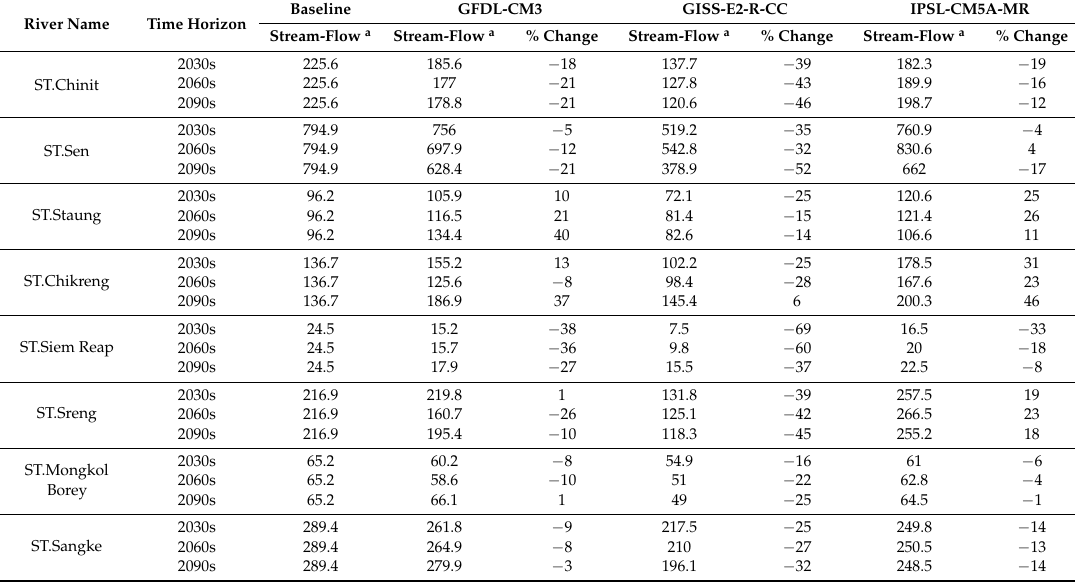
Table 6. Percentage changes in Q 5 for the three GCMs in the three scenario